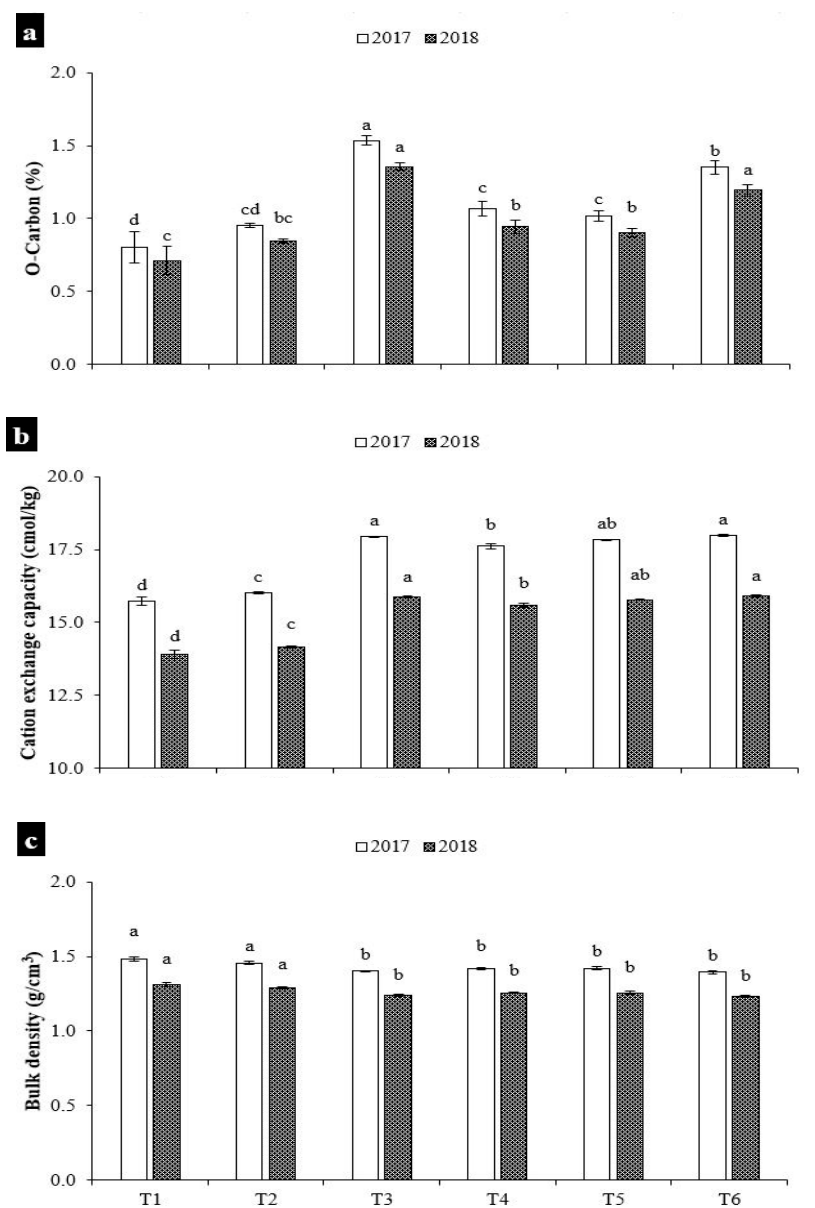
Figure 3. E ff ect of organic, inorganic, and biofertilizers on the soil properties [O-carbon ( a ), cation exchange capacity ( b ) and bulk density ( c )] on which Jew’s mallow ( Corchorus olitorius L.) was grown. Each column represents the mean of three replicates; different letters on similar columns indicate significant differences using Duncan’s multiple range test at p ≤ 0.05.